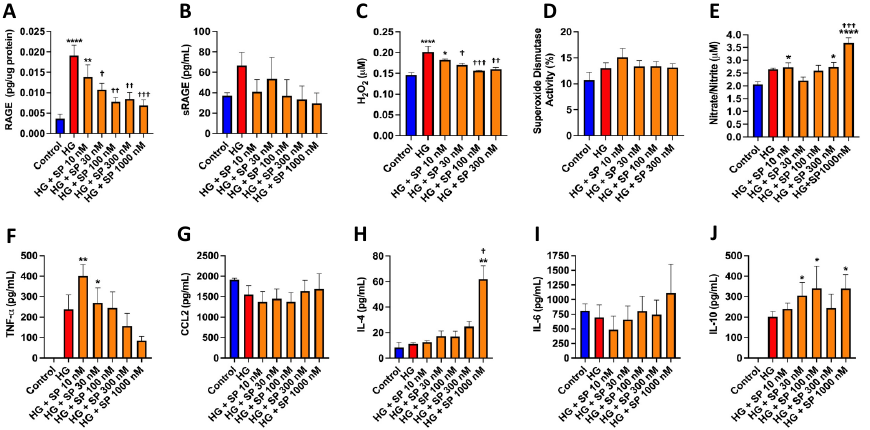
Figure 3. SP reduces RAGE and oxidative stress while increasing nitric oxide in isolated cardiac fibroblasts in response to high glucose. ( A ) Receptor for advanced glycation end product (RAGE) in cardiac fibroblast lysates; ( B ) soluble RAGE (sRAGE); and ( C ) hydrogen peroxide (H 2 O 2 ) in the culture media of isolated cardiac fibroblasts in response to normal glucose (control, 5 mM), high glucose (HG, 25 mM), and HG with increasing concentrations of SP (10 to 1000 nM); ( D ) superoxide dismutase levels in cardiac fibroblast lysates in response to control, HG, and HG with increasing concentrations of SP; ( E ) total nitrate/nitrite as a marker of nitric oxide (NO) production in the culture media of isolated cardiac fibroblasts in response to control, HG, and HG with increasing concentrations of SP. SP alters cytokine production by isolated cardiac fibroblasts in response to high glucose. ( F ) TNF- α , ( G ) CCL2, ( H ) IL-4, ( I ) IL-6, and ( J ) IL-10 levels in isolated cardiac fibroblast cell culture media in response to normal glucose (control, 5 mM), high glucose (HG, 25 mM), and HG with increasing concentrations of SP (10 to 1000 nM). Data are expressed as mean ± SEM and were analyzed by one-way ANOVA with Tukey post hoc test; * p < 0.05 vs. control, ** p < 0.01 vs. control, **** p < 0.0001 vs. control, † p < 0.05 vs. HG, †† p < 0.01 vs. HG, ††† p < 0.001 vs. HG. n = 4–6 for control and n = 5–6 for all other